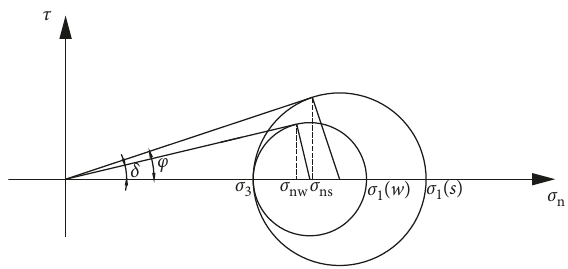
Figure 3: 2D Mohr stress circles for the wall-soil interface and its horizontally corresponding slip surface.